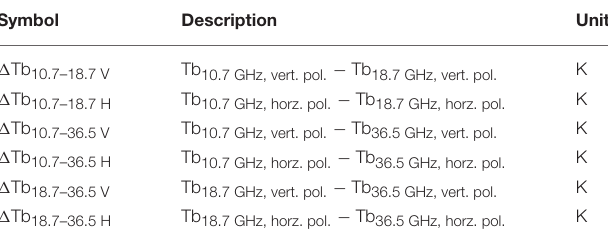
TABLE 3 | List of brightness temperature (Tb) spectral difference training targets used during SVM training.